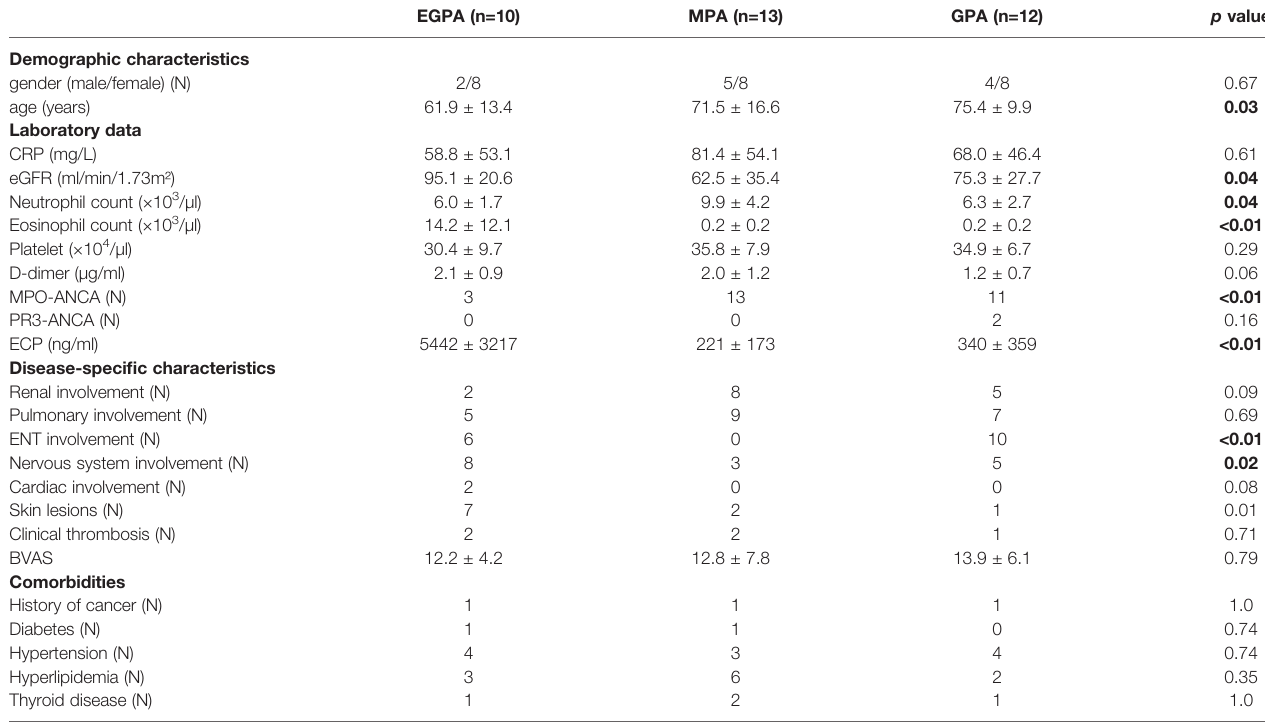
TABLE 1 | Patient characteristics at